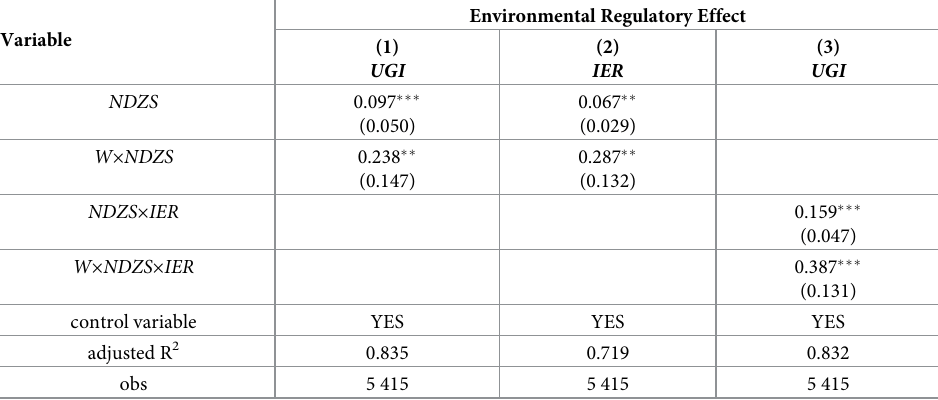
Table 11. Mechanism test-environmental regulatory effect.